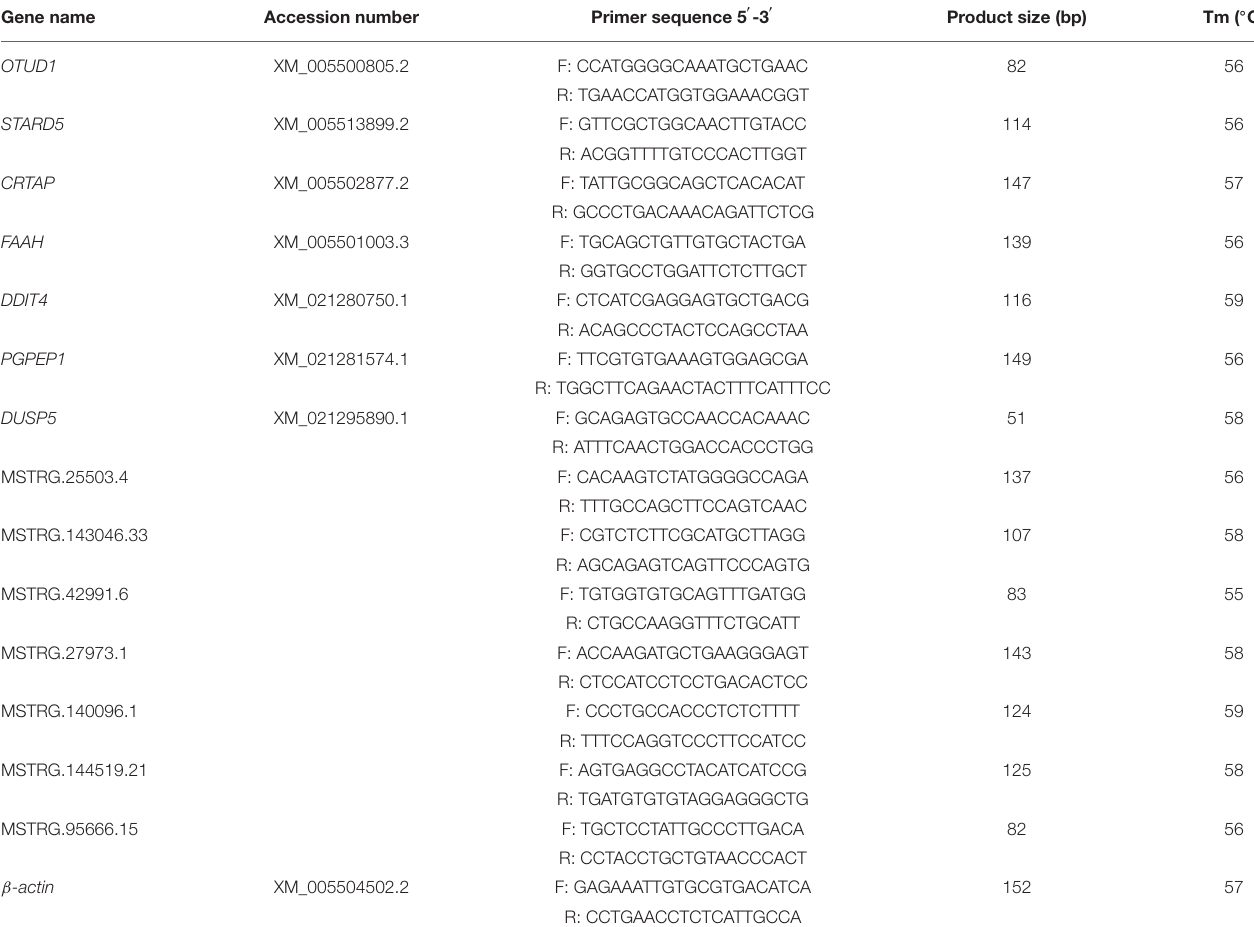
TABLE 3 | Primers used for quantitative real time